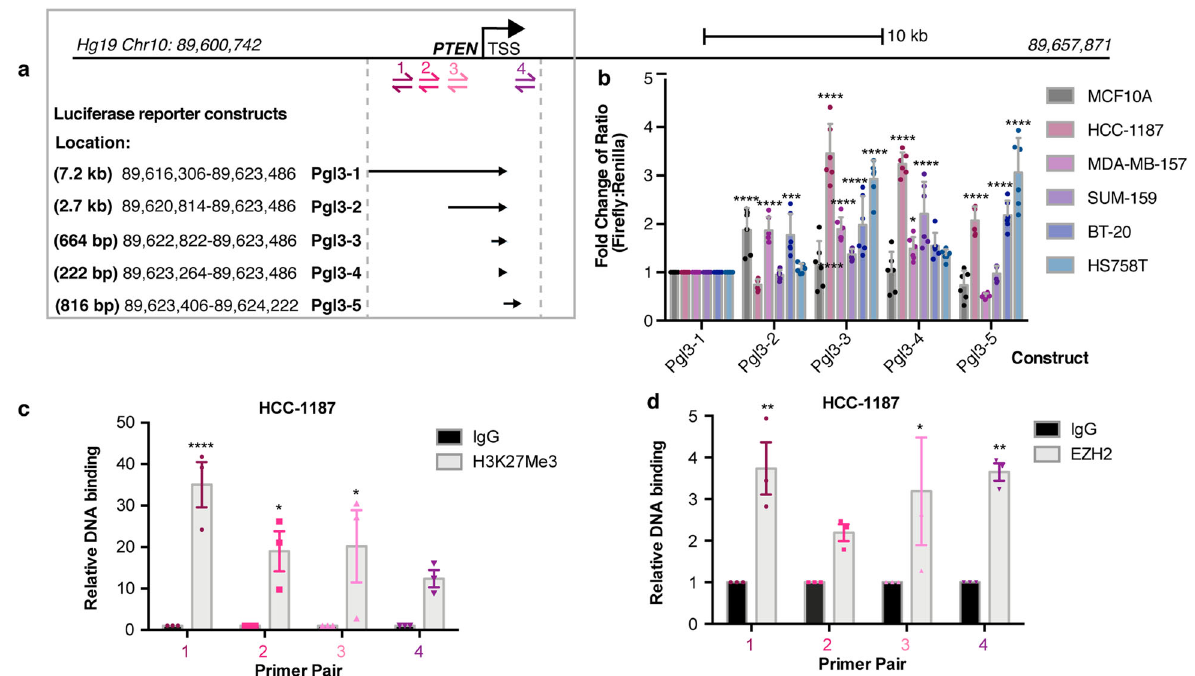
Fig. 2 Mapping transcriptional repression of the PTEN promoter. a Map of the PTEN promoter and upstream regulatory region where primer sites for ChIP-qPCR are shown (Sites 1 – 4). Location of luciferase reporter constructs 23 , Hg19 genomic loci on Chr.10, and length in base pairs listed. b Luciferase activity normalized to Renilla for each luciferase construct calculated as a fold change from Pgl3-1 construct. Cell line is indicated. Error bars are mean ± s.d. (mean of six measurements: two biological replicates, triplicate measurements each). Signi fi cance from Pgl3-1: two-way ANOVA, Dunnett ’ s correction. c , d ChIP-qPCR in HCC-1187 cells for ( c ) H3K27Me3 and ( d ) EZH2 at indicated regions (1, 2, 3, 4) of the PTEN promoter. Relative DNA binding is % input normalized to IgG. Error bars: mean ± s.e.m., n = 3 experiments. Signi fi cance from IgG: two-way ANOVA, Sidak ’ s correction. (**** P < 0.0001; *** P < 0.001; ** P < 0.01; * P <